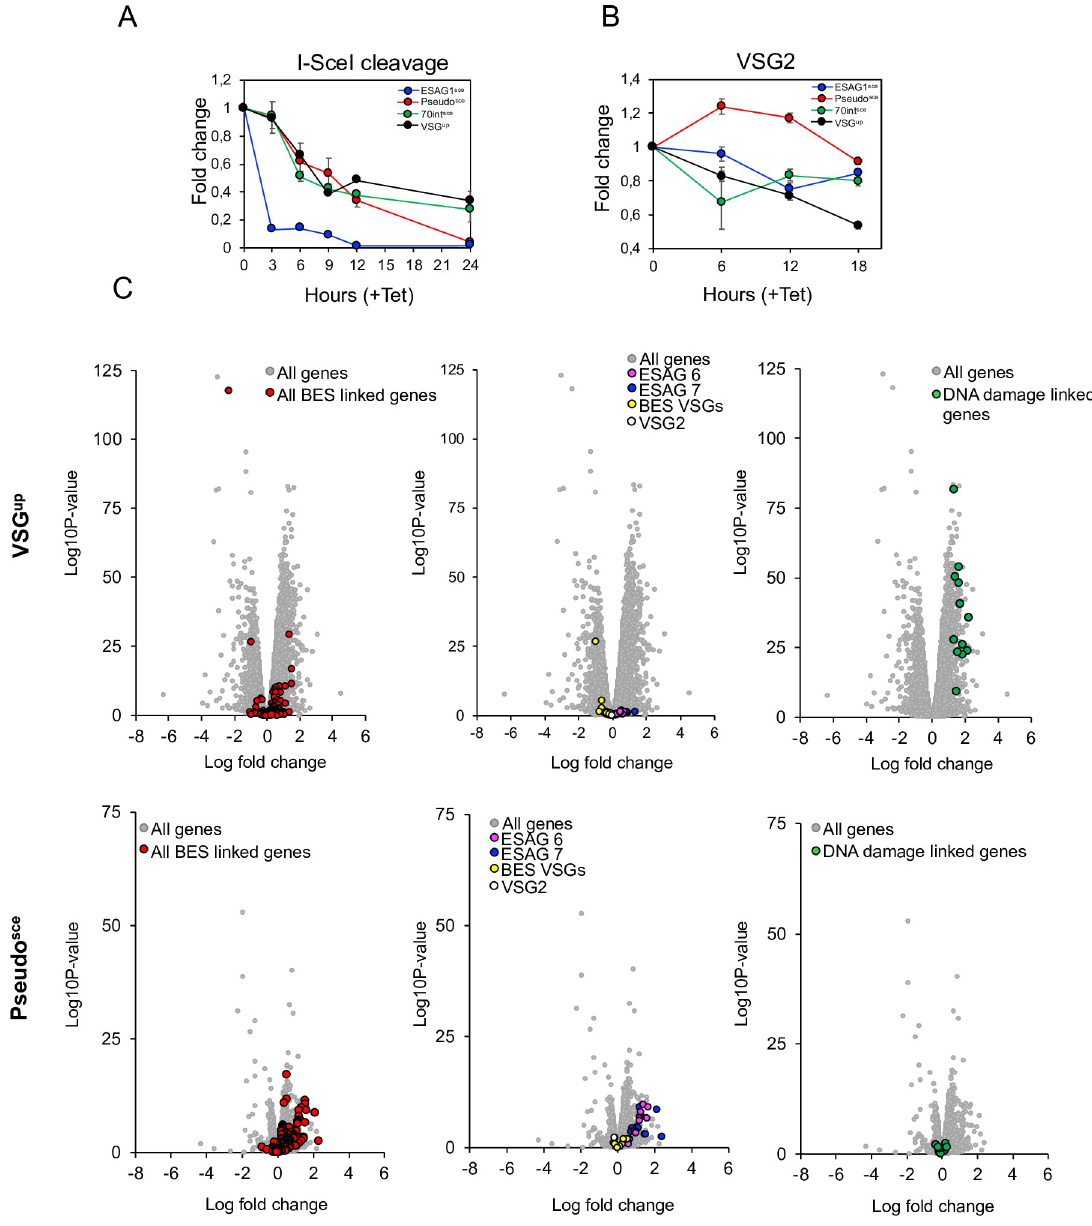
Fig 4. A DNA break at the active BES elicits a specific change in gene expression. (A) qPCR assay to assess I-SceI cleavage following induction. (B) RT-qPCR analysis of the expression levels of VSG2 at 6-hour intervals following an I-SceI DNA break. (C) RNA-seq analysis at 6 hours following a DSB in the VSG up cell line and the Pseudo sce cell line. Values are averages of three independent replicates relative to wild-type controls. Red circles BES linked genes; yellow circles BES VSGs; white circle, VSG2; pink circles, BES ESAG6 ; blue circles, BES ESAG7 ; green circles, DNA damage linked genes (All genes are included in S1